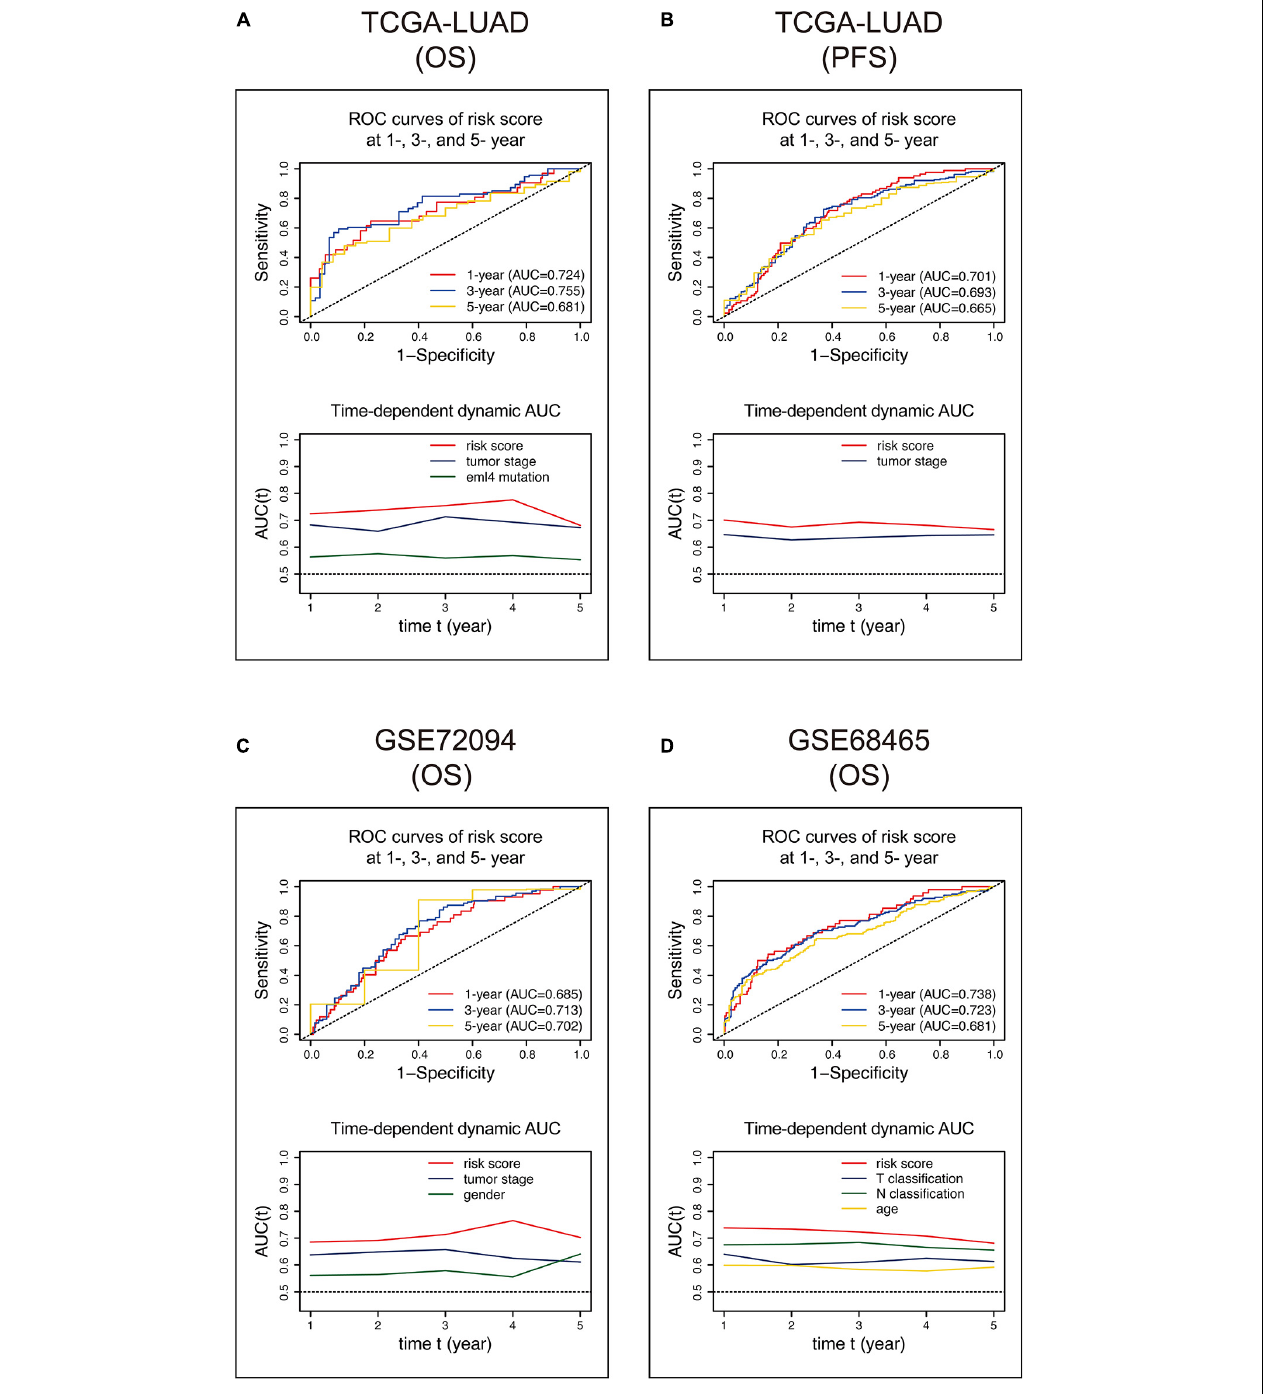
FIGURE 5 | ROC and time-dependent dynamic AUC curves of the 15-gene signature risk score in the training (A,B) and validation (C,D) cohorts. The ROC curve shows prognostic abilities with risk scores at 1, 3, and 5 years. The time-dependent dynamic AUC curve shows a comparison between the risk score and other independent factors. ROC, receiver operating characteristic; AUC, area under the ROC